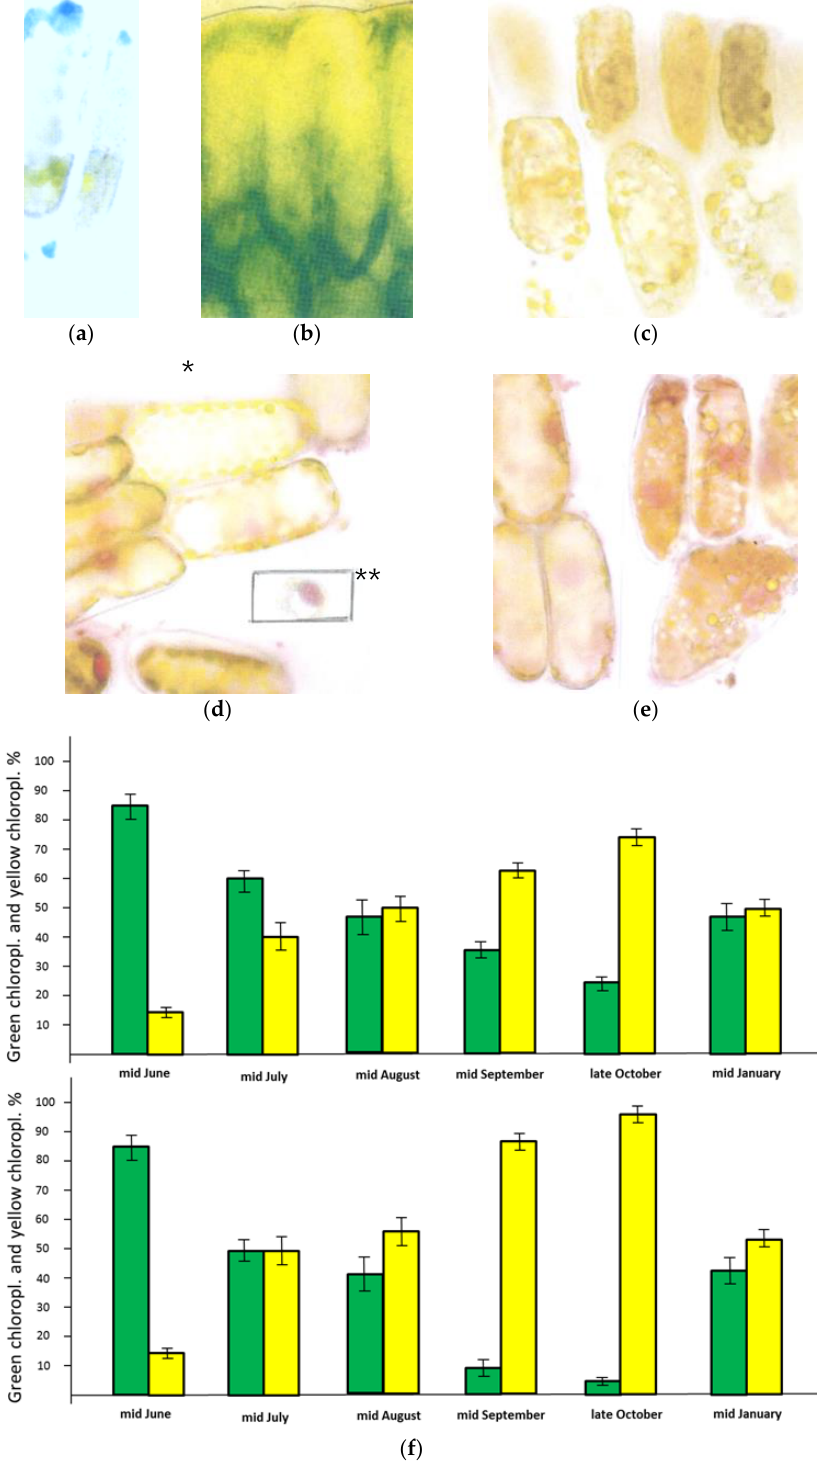
Figure 6. ( a – f ) Distribution of flavanols (blue), flavonols (yellow), and DNA (red) in the cells of the palisade tissue. palisade